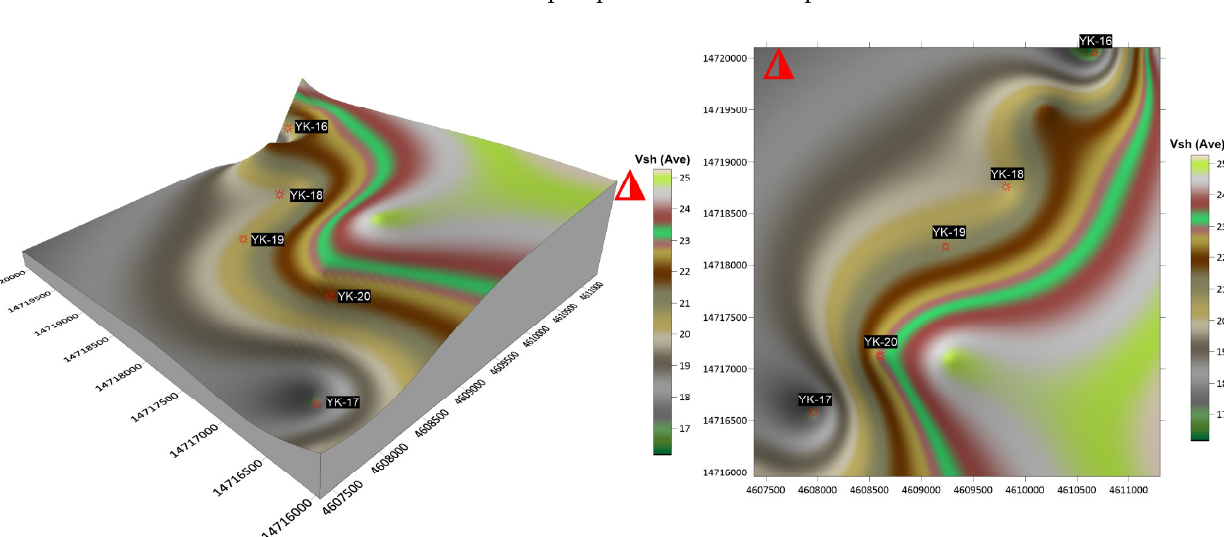
Figure 13. Φeff map (calculated in %).